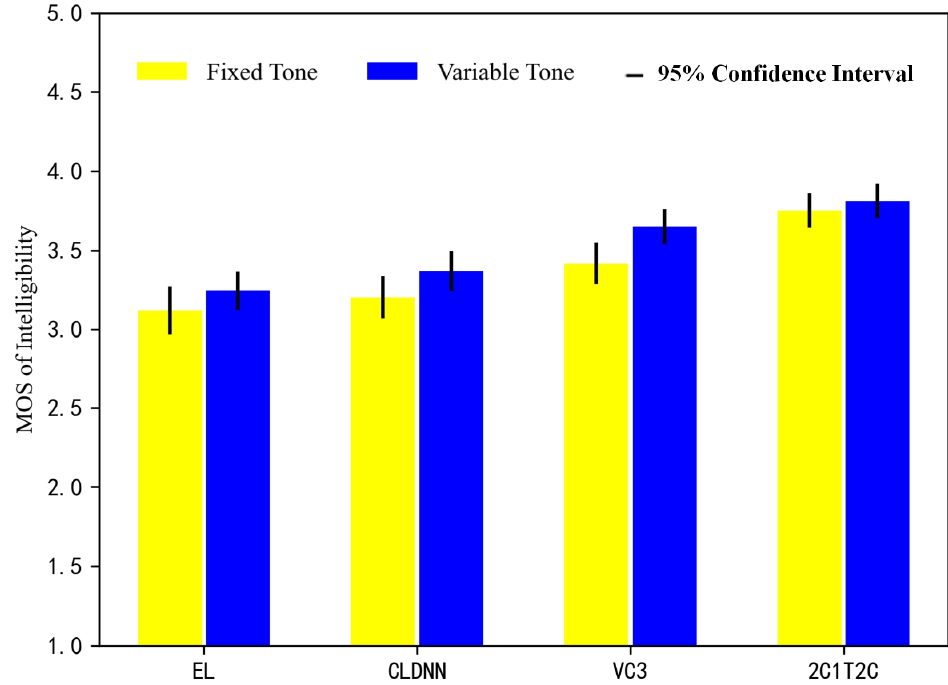
Figure 5. MOS for intelligibility with 95% confidence intervals.